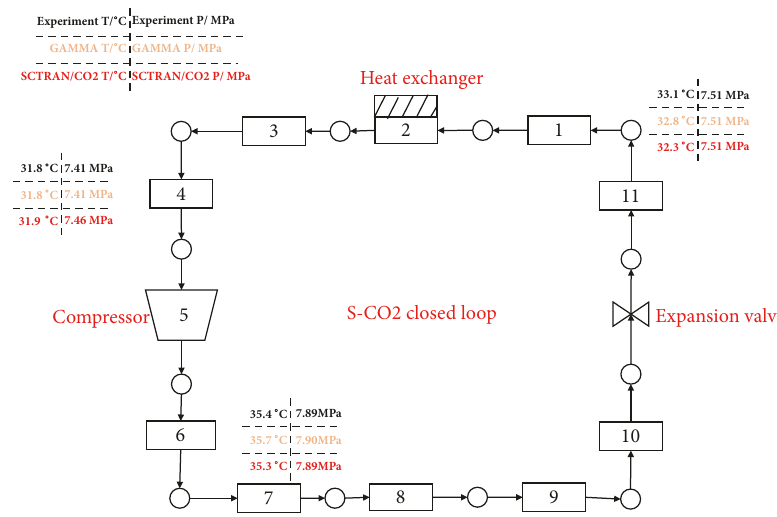
Figure 13: Nodalization of SCTRAN/CO2 model and steady-state result at each